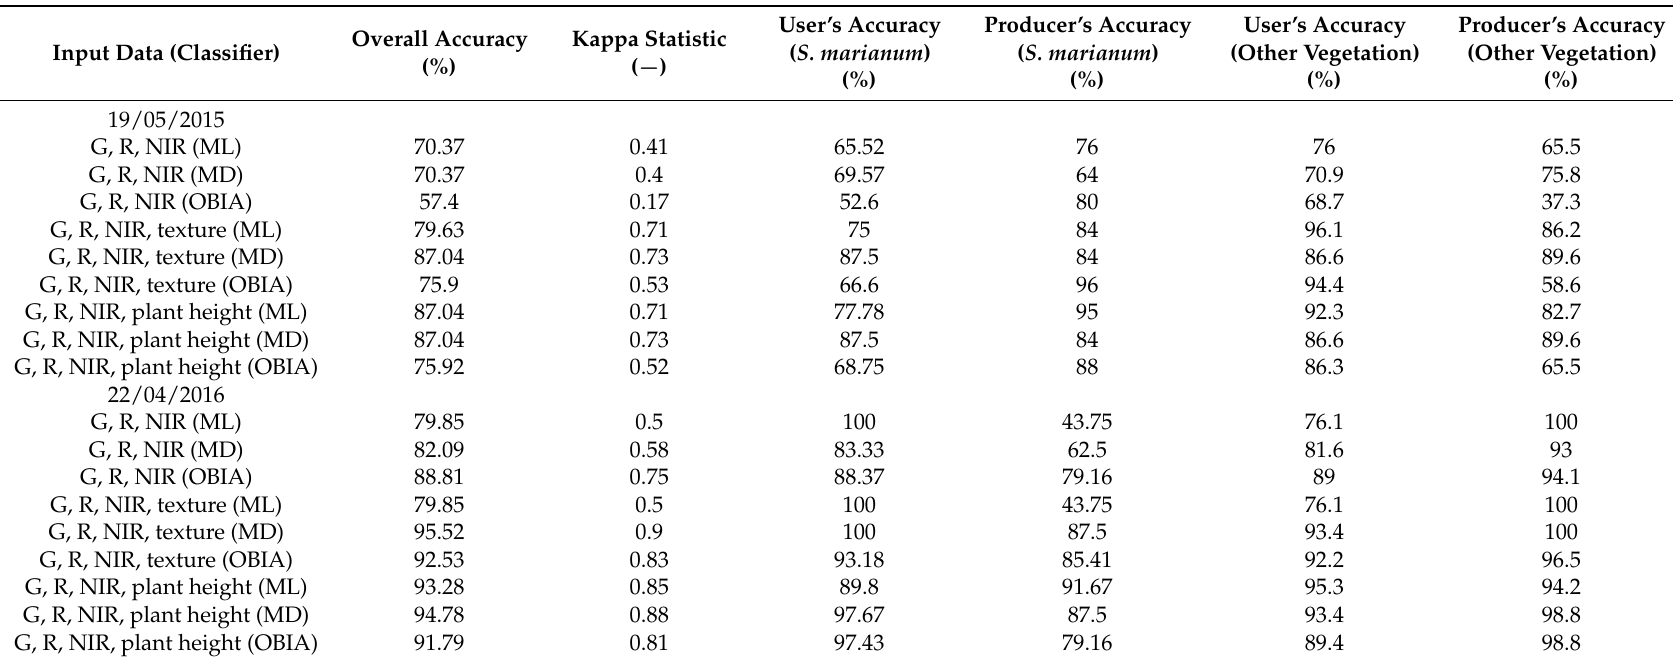
Table 1. Classification accuracy using independent validation samples (ML is maximum likelihood, MD is minimum distance, G, R and NIR are the green, red and near-infrared bands of the UAV orthomosaics,